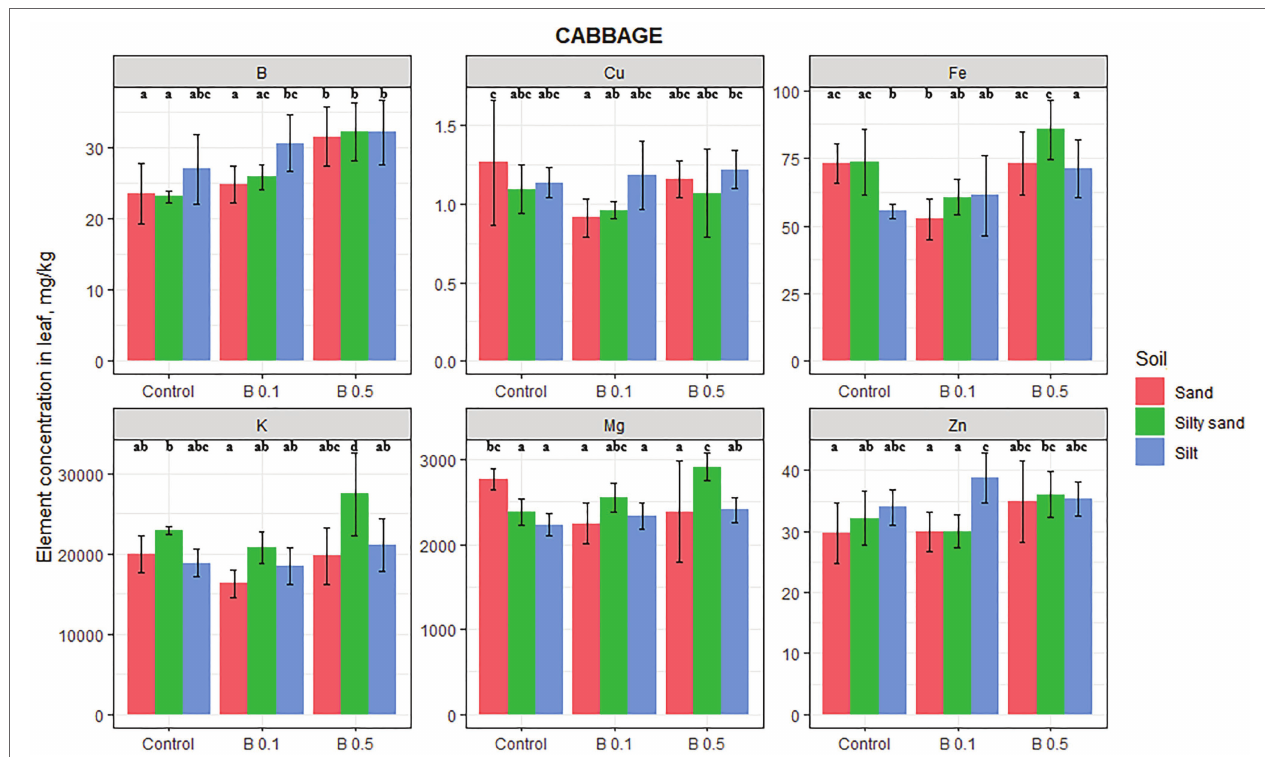
FIGURE 4 | Element contents in cabbage leaf in different irrigation water treatments on sand, silty sand, and silty soil (mg/kg DW). The data are means of the replicates. Different letters (a–d) indicate significant differences between treatments ( p <